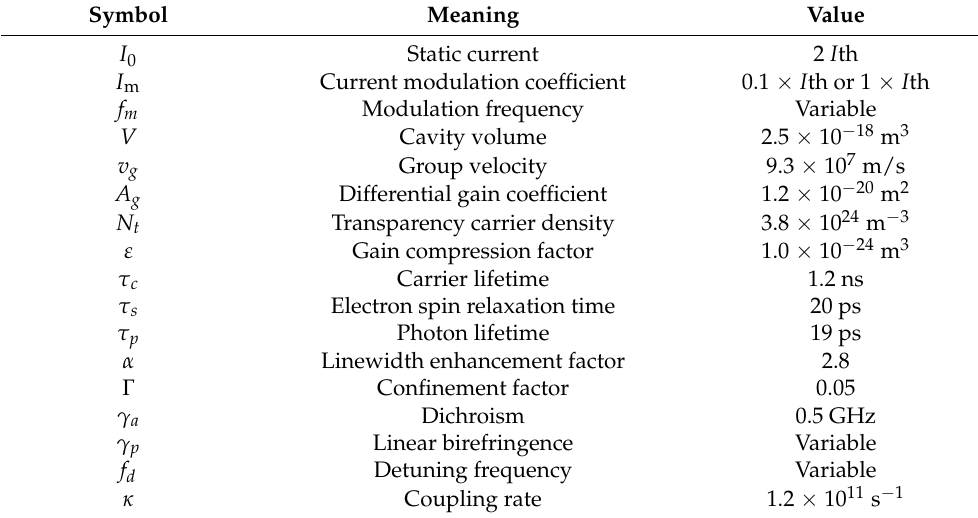
Table 1. Simulation parameters. I th denotes threshold